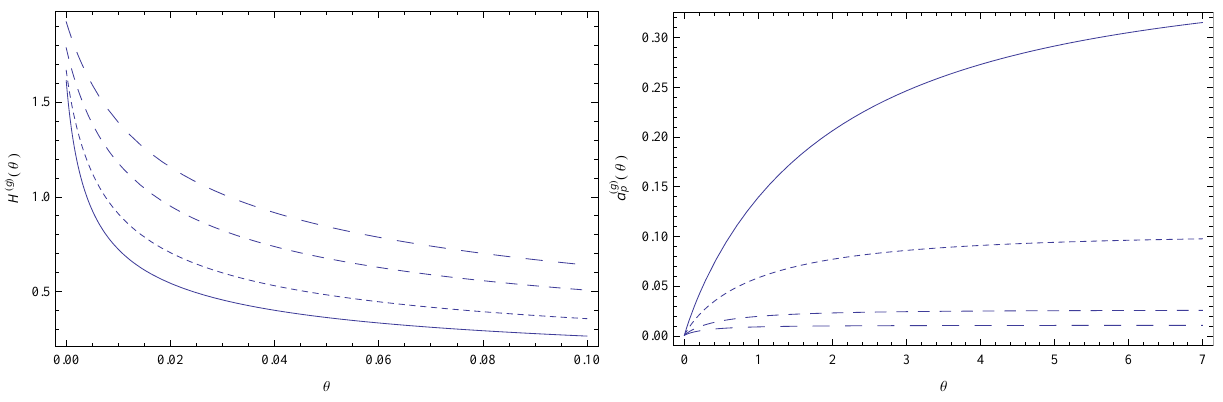
Figure 2. Variation of the dimensionless Hubble function H ( g ) of the stiff fluid filled Bianchi type I space-time in EiBI gravity ( left figure) and of the mean anisotropy parameter a ( g ) the physical space g ( right figure), for different initial values of the dimensionless energy density r : r (0) = 0 . 155 (solid curve), r (0) = 0 . 15 (dotted curve), r (0) = 0 . 14 (short dashed curve) and r (0) = 0 . 13 (dashed curve), respectively. As before, we have considered r (cid:48) (0) = − 1 . 5 for all